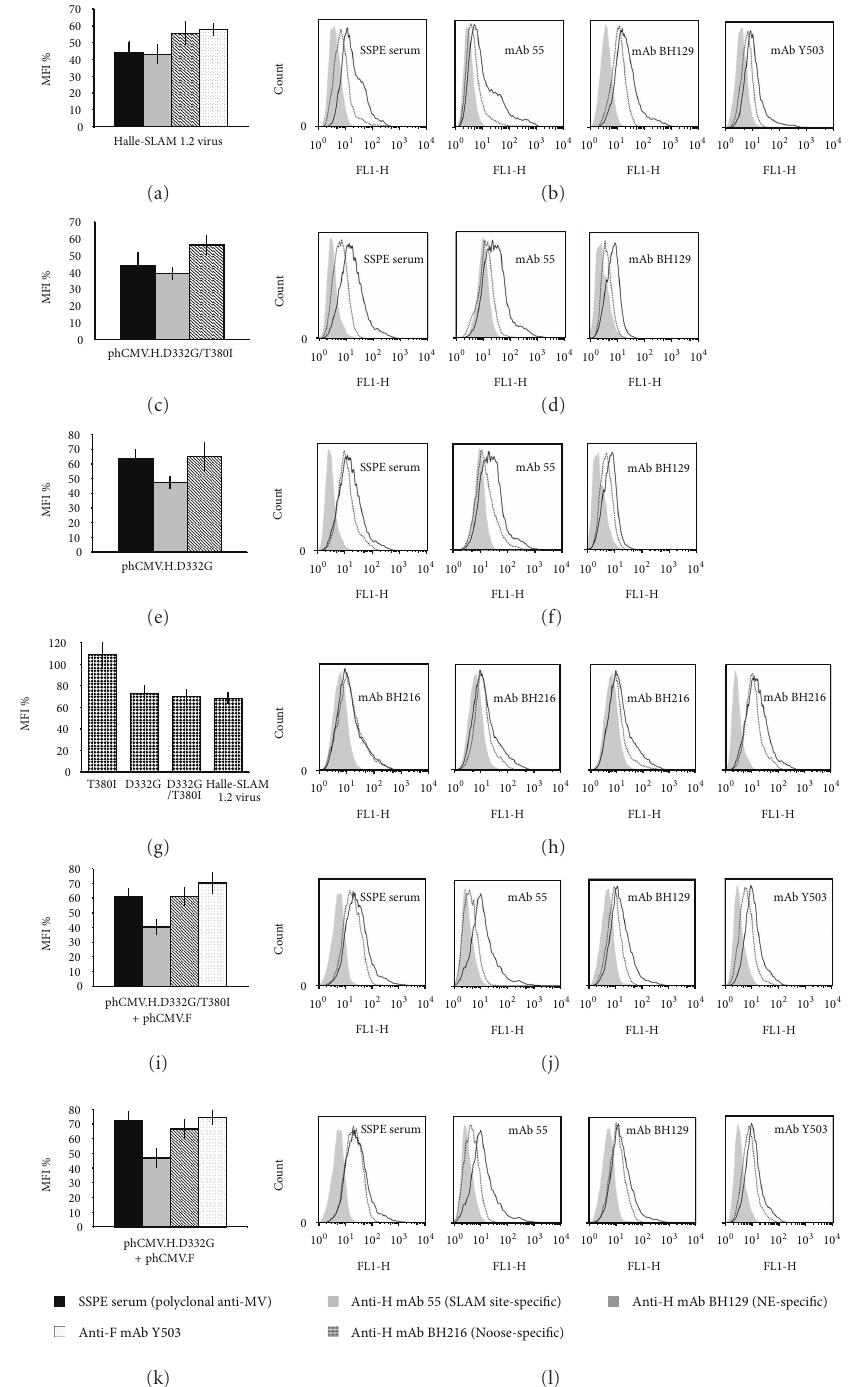
Figure 1: Flow cytometry analysis of escape mutant Halle-SLAM 1.2 (H: D332G, T380I; F: no change; M: Y114H, I319T). Vero-SLAM cells infected with the escape mutant virus or transfected with phCMV plasmids expressing the mutated H protein, either alone or with a phCMV plasmid expressing the nonmutated F protein, in the presence of antifusion tripeptide FIP were analysed 1 day after infection (or after transfection) using the indicated antibodies. Each overlay histogram plot represents one representative experiment; the MFI histogram data represent the mean percentages ± standard deviations for three such experiments. These values were obtained by using nonmutated Halle virus or expressed nonmutated Halle proteins as controls. (a) and (b) escape mutant Halle-SLAM 1.2-infected cells; ((c) and (d)) and ((e) and (f)), cells transfected with phCMV.H.D332G/T380I and phCMV.H.D332G, respectively; (g) and (h) cells transfected with different phCMV.H mutants or infected with the escape mutant; ((i) and (j)) and ((k), (l)), cells cotransfected with phCMV.F + phCMV.H.D332G/T380I or phCMV.H.D332G,